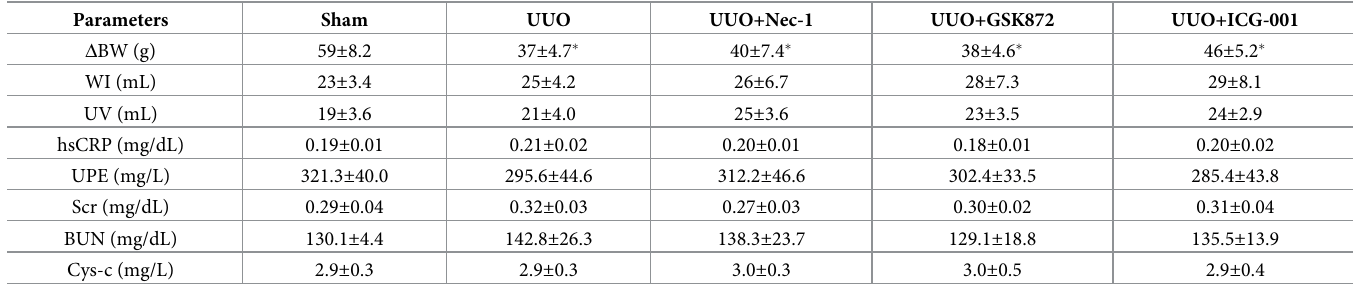
Table 1. Basic parameters in the experimental groups.